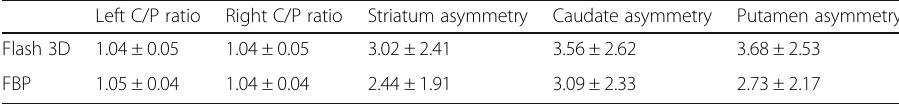
Asymmetries are given in %. Values are mean±SD . FBP filtered back projection, C/P caudate-to-putamen